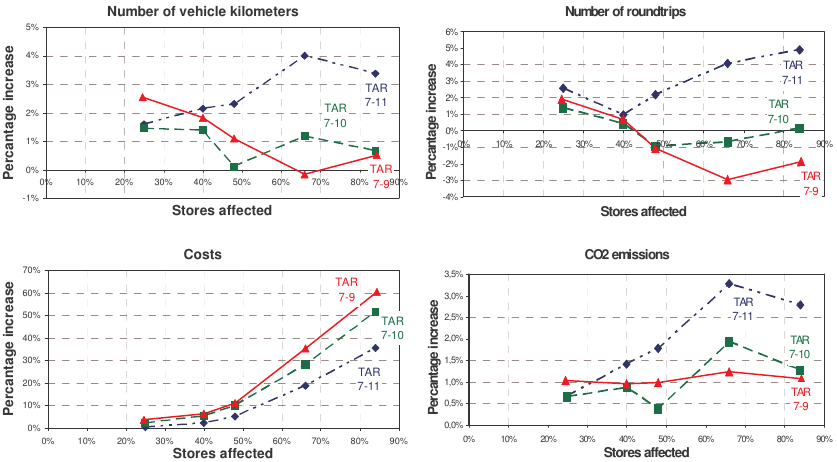
Figure 7. Values for FR2 and the time access restriction policy measure FR3’s number of vehicle kilometers and roundtrips show an increasing trend in scenario A (figure 8). When 50% of the stores are affected, extra truck capacity is hired, which results in a decrease in the number of kilometers. Although beyond this point even more capacity is hired, the stores that still were combined up to this point are now also affected. The